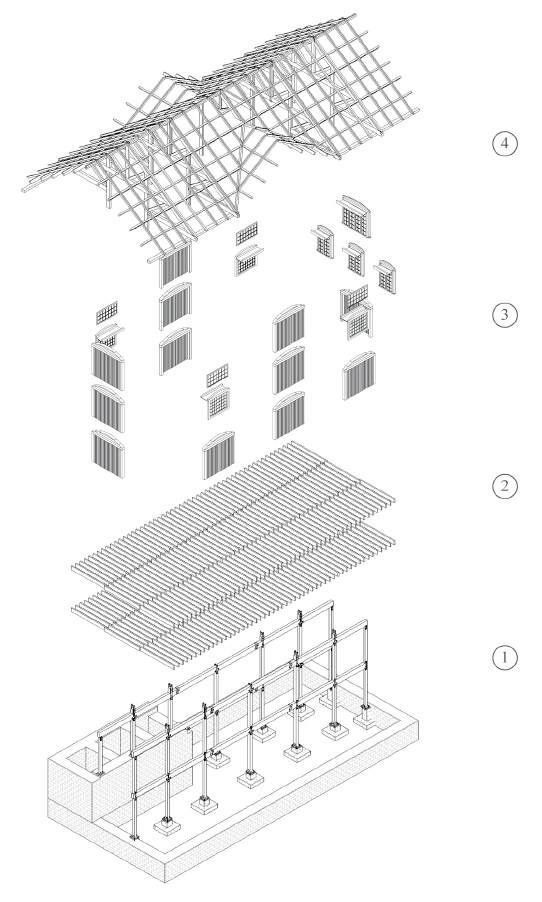
Figure 4. Parametric categories: 1. Footings and vertical structure; 2. Horizontal structure; 3. Openings; 4. Roof structure. Roof and wooden